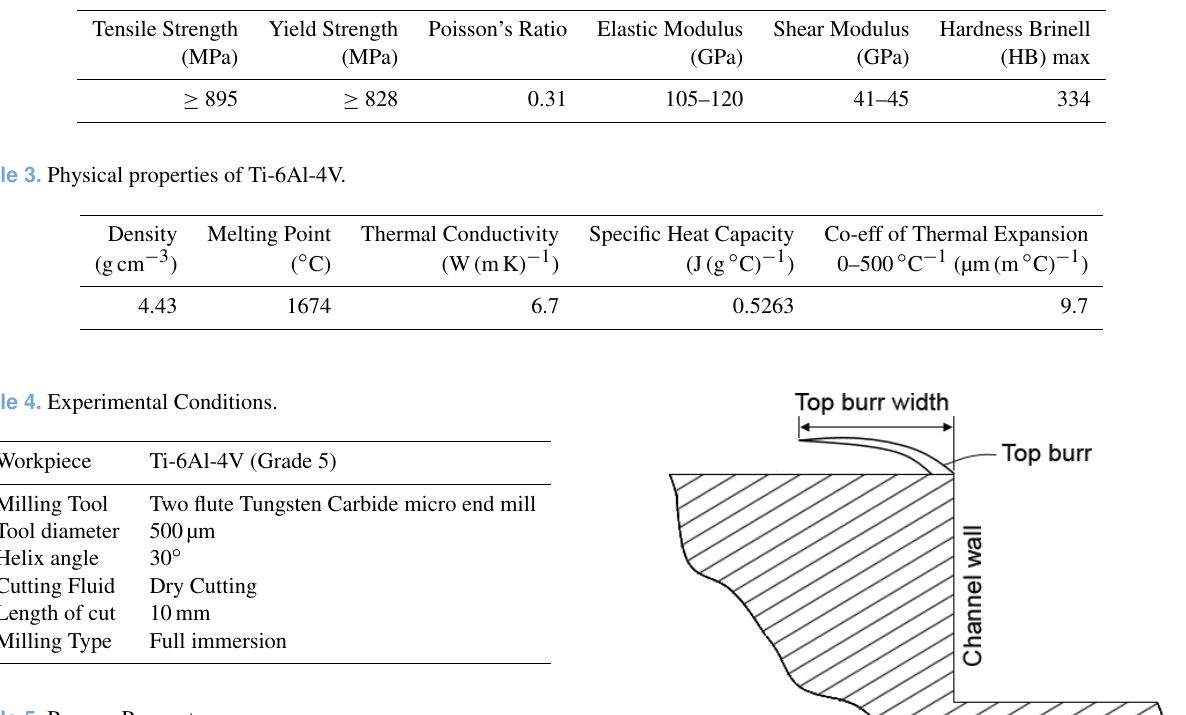
Table 5. Process Parameters.